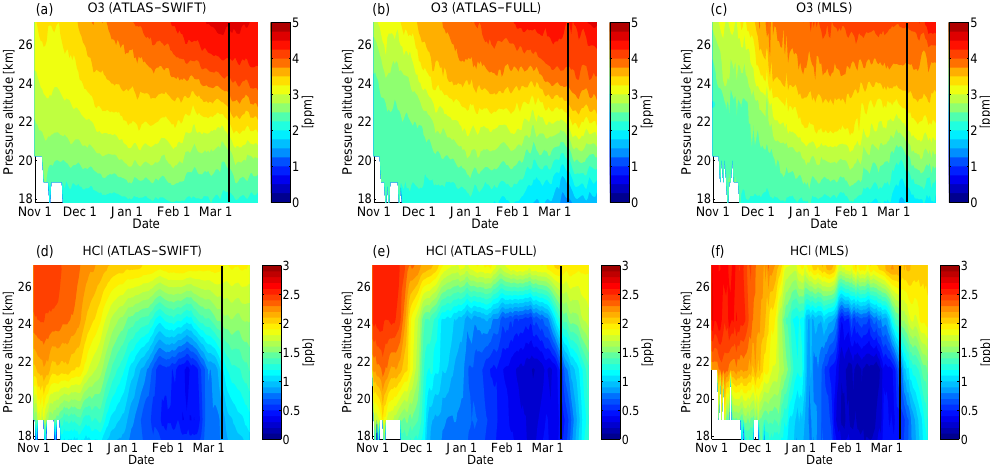
Figure 17. Time evolution of vortex means of O 3 and HCl in the northern hemispheric winter 2004/2005 for Polar SWIFT driven by the ATLAS transport model (a) , for the full chemistry model of ATLAS driven by the ATLAS transport model (b) and for MLS satellite measurements (c) . The black line marks the approximate breakup date of the vortex.